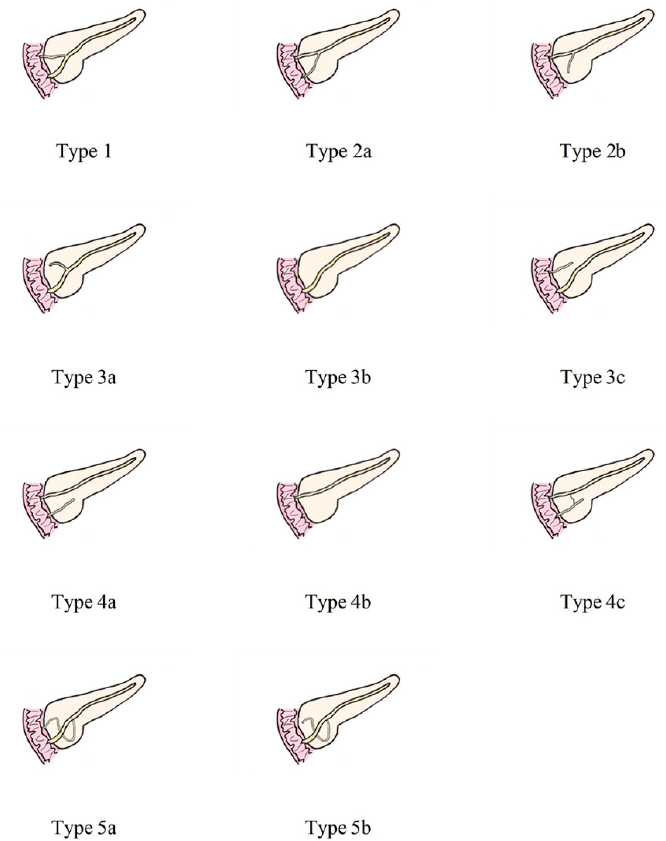
Figure 2. Anatomical classification of pancreatic duct system. Type 1: MPD drainage to MP, APD drainage to MiP, local communication; Type 2: MPD drainage to MiP, APD drainage or non-drain-